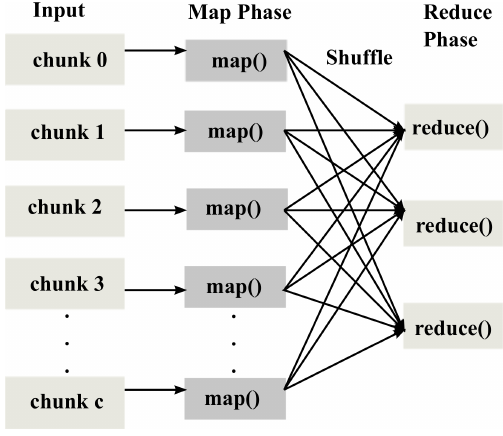
Figure 1. Map-Reduce Model.